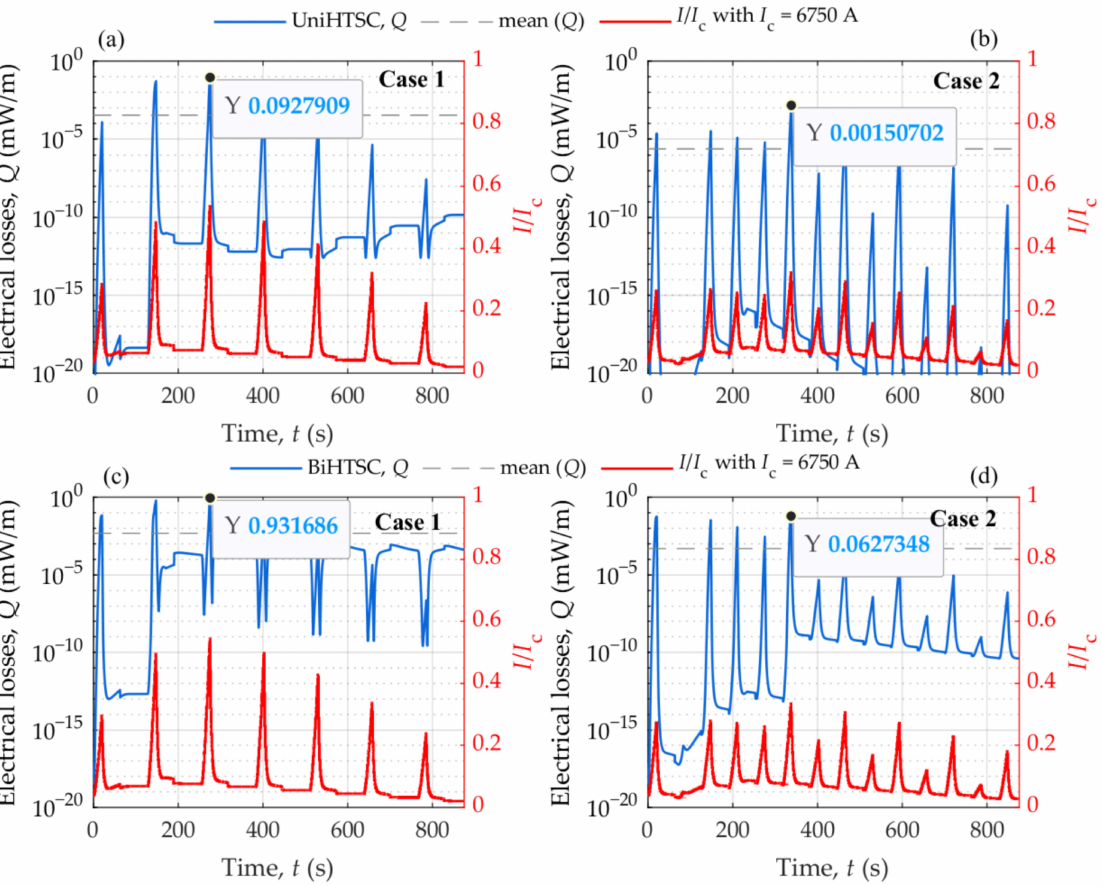
Figure 22. AC losses of the superconducting cable as a function of time; the second y-axis, on the right side of the figures, is the ratio I / I c , with I c being the critical cable current. ( a , b ) present the losses of the unipolar cable for the scenarios 1 and 2; ( c , d ) present the losses of the bipolar cable for the same